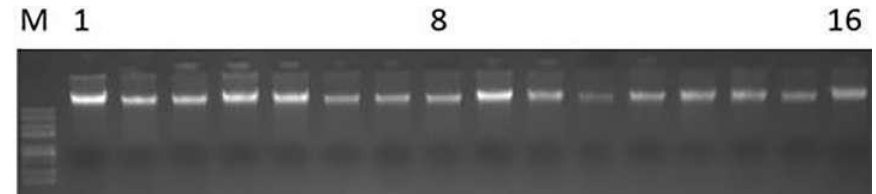
Figure 1. DNA gel electrophoresis.